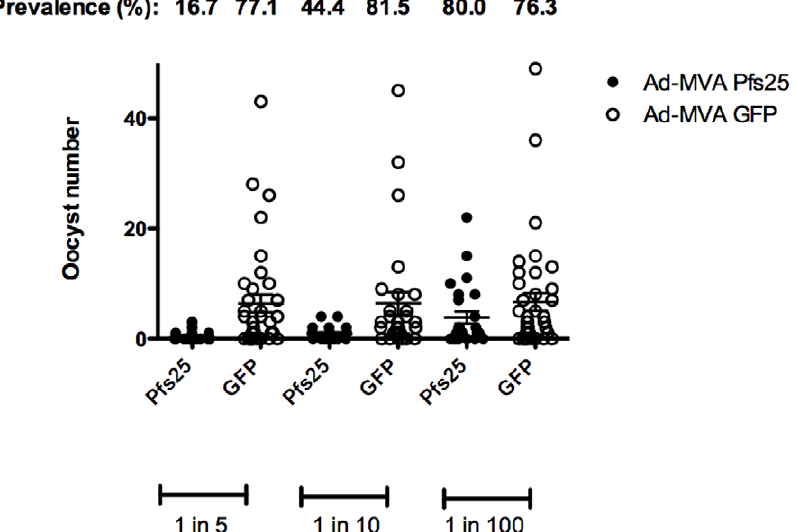
Figure 7. Parasite infectivity via membrane feeding asssay (per mosquito) following Ad-MVA Pfs25 immunization. Sexually mature P. falciparum NF54 cultures were mixed with anti-Pfs25 serum from a representative Ad-MVA immunized mouse (Pfs25) or negative control anti-GFP serum (GFP) at final dilutions of 1 in 5, 1 in 10 and 1 in 100. Data points represent the number of oocysts found in individual mosquitoes 12 days post feed. Horizontal lines indicate the mean number of oocysts ( + / 2 sem).